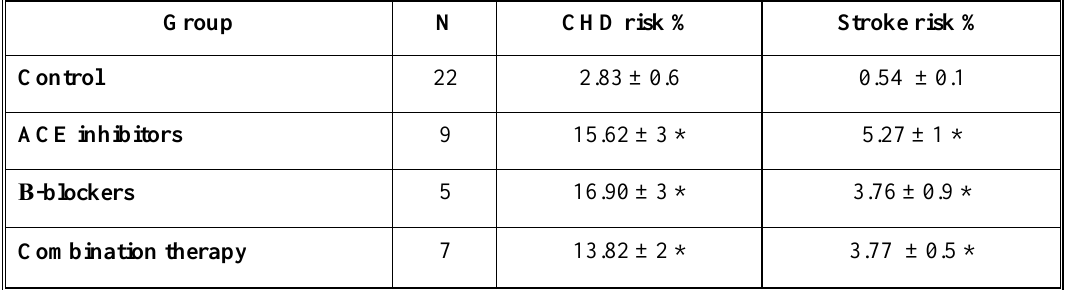
Table 14: CHD risk % and stroke % based on DBP in control healthy individuals and retrospective diabetic hypertensive patients treated with different antihypertensive drugs. Each value represents mean± standard error of